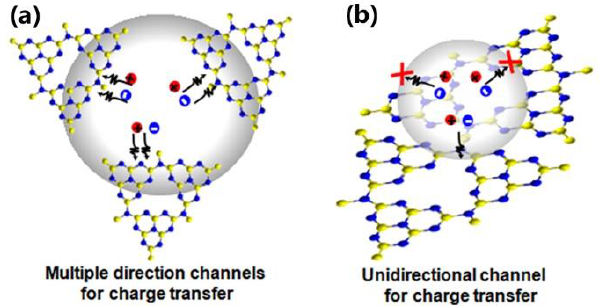
Figure 13. Structure of HTCN-1 ( a ) and C-T ( b ). Reprinted with permission from [106]. Copyright 2018, Elsevier.